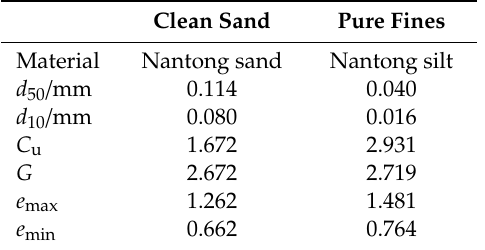
Figure 2. Scanning electron microscopy image and grain size distributions of clean sand, pure fines, and marine silty sand with different fines content: ( a ) grain size distribution; ( b ) scanning electron microscopy image. Table 1. Index properties of clean sand and pure fines.